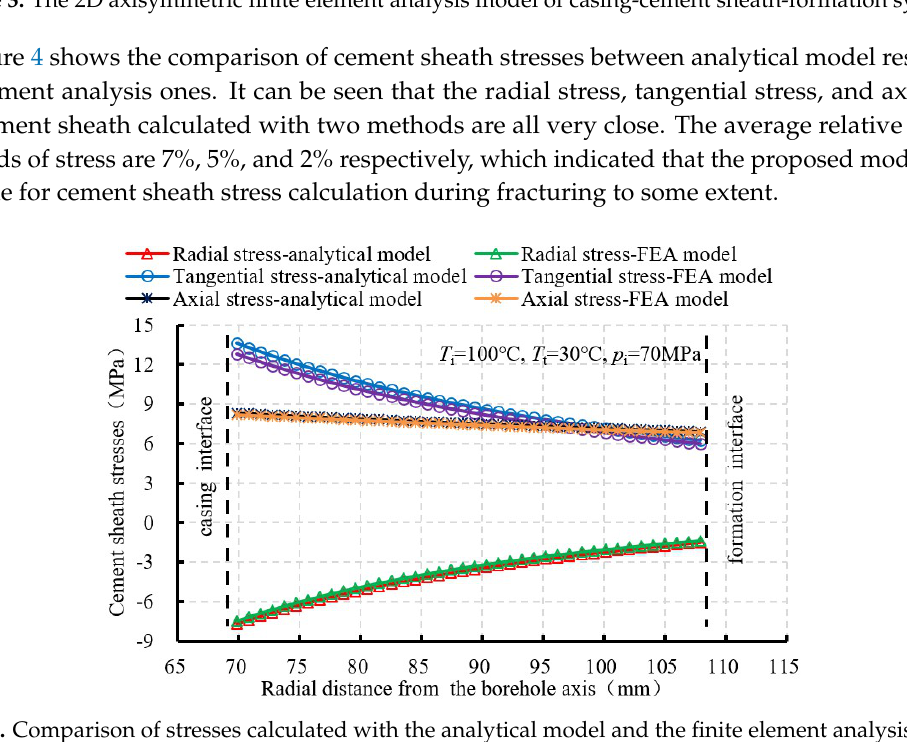
Figure 4. Comparison of stresses calculated with the analytical model and the finite element analysis